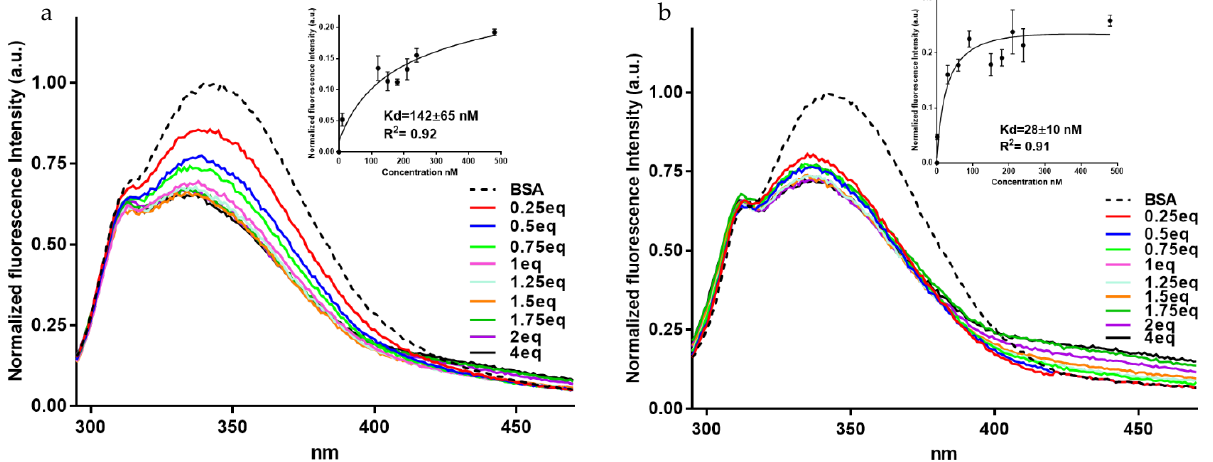
Figure 4. Fluorescence titrations of BSA (120 nM) with ( a ) BDF1 and ( b ) BF1 with ligand concen- trations from 30 to 480 nM. Insets: changes in the normalized fluorescence intensity as a function of ligand concentrations (nM) for the titrations of BSA with BDF1 and BF1, after the DMSO back- ground subtraction. k D values with standard deviations determined by the fluorescence method are also reported.